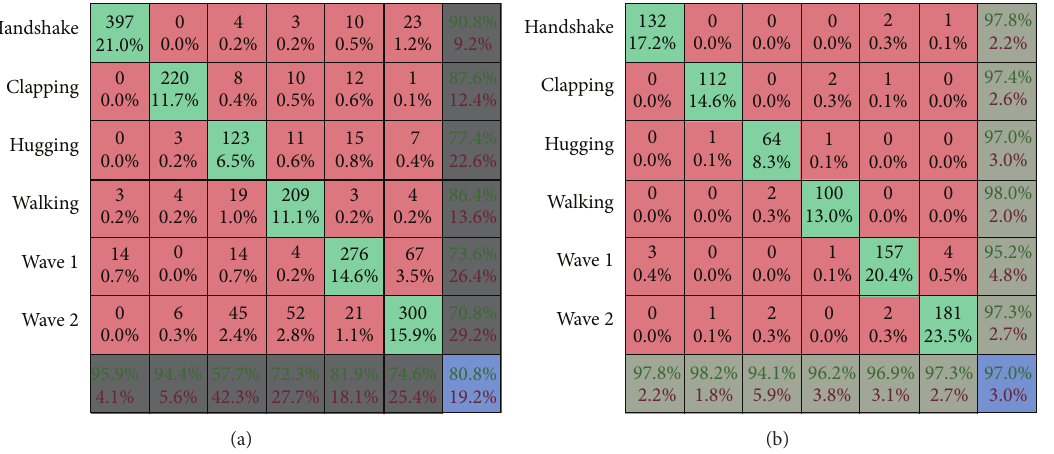
Figure 7: (a) The confusion matrix formed for all the frames. (b) The confusion matrix formed for medial frames.